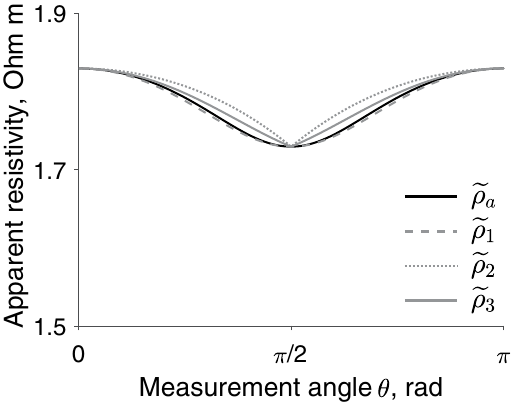
Figure 3. Apparent resistivity ρ a = real( κ a ) from (3) (solid black line) and the corresponding approximations real( in (8) (dashed grey line), real( a,2 ˆ κ = in (9) (dotted grey line), ρ κ = ˆ ˆ real( ) grey line). Simulation settings: aspect ratio p = 8.6, anisotropy ratio α 2 = 0.5, measured frequency f = 10 kHz, transverse resistivity ρ T = 2.93 Ω